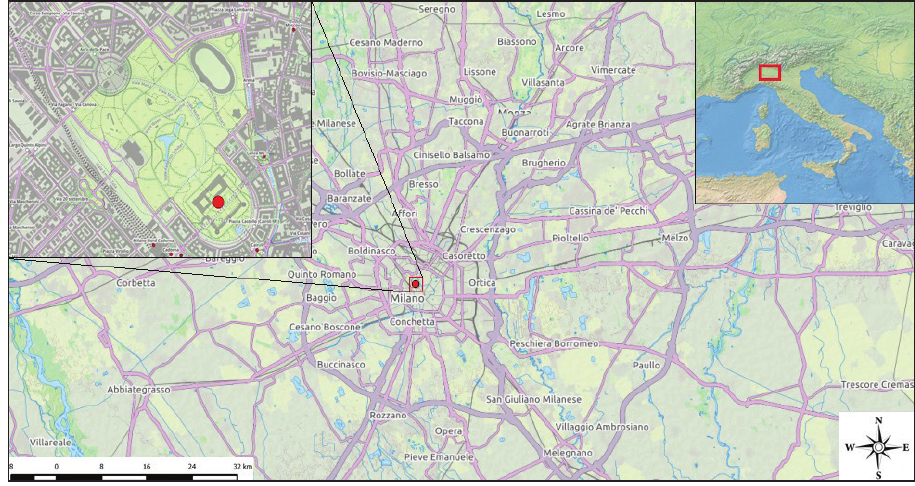
Figure 6. Distribution map of Hieracium australe subsp. australe